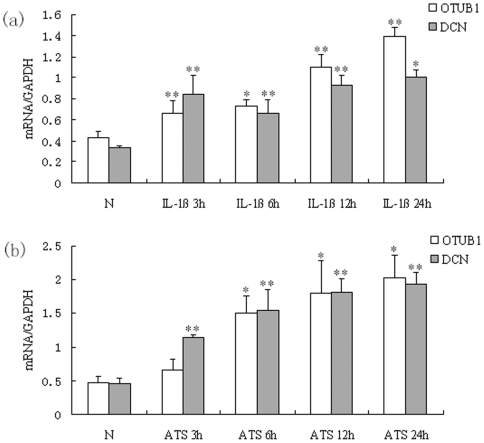
OTUB1 and DCN mRNA were upregulated in MC stimulated with IL-1βand ATS.(a) MC were treated with IL-1β10 ng/mL for 3 h, 6 h, 12 h and 24 h. (b) MC were treated with ATS 30 µL/mL for 3 h, 6 h, 12 h and 24 h respectively. mRNA levels of OTUB1 and DCN in MC were analyzed by quantitative real-time PCR. Besides the group of OTUB1 in ATS treating for 3 h, both OTUB1 mRNA and DCN mRNA significantly increased in all groups treated with IL-1β or ATS compared with normal group (*P<0.05, **P<0.01). Data are presented as mean±standard error (SE) from at least three individual experiments carried out in duplicate.